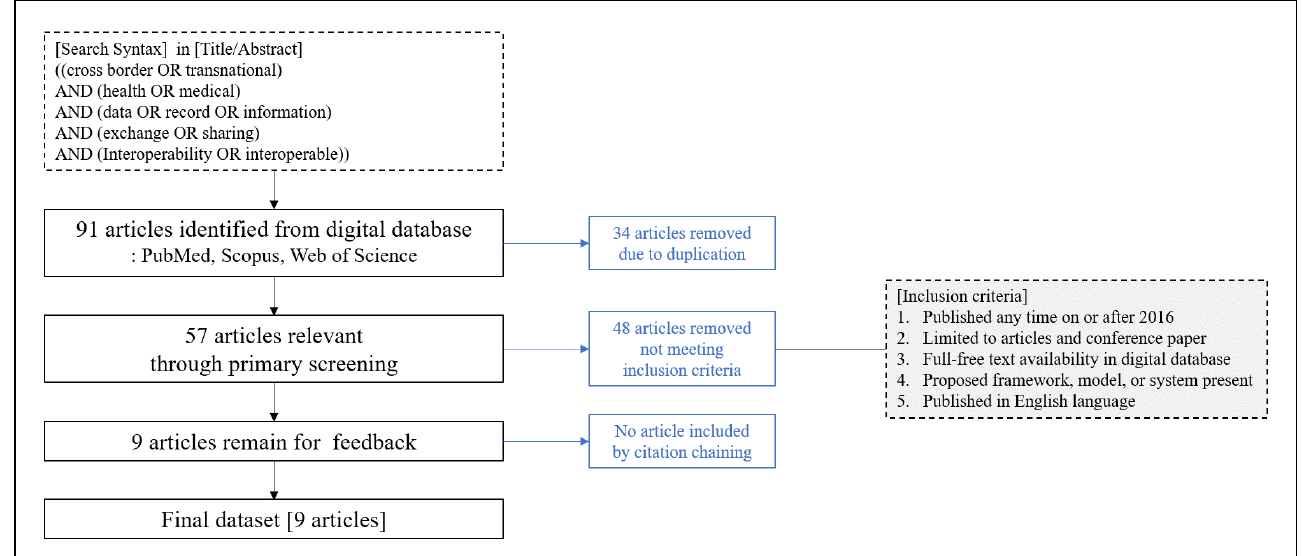
Figure 1. Selection criteria for previous studies on health information exchange